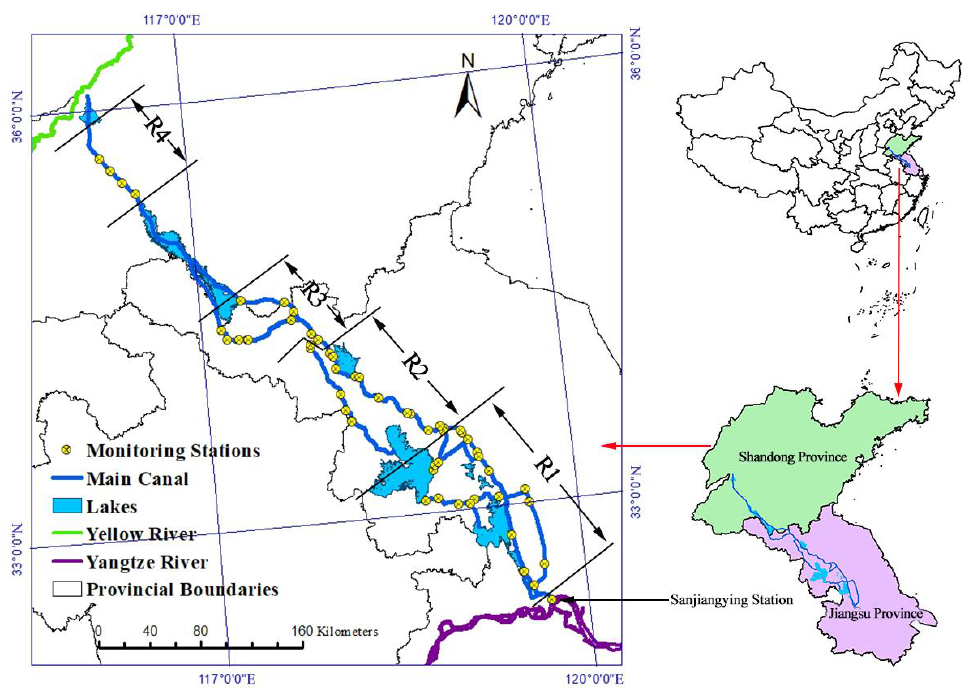
Figure 1. Map of the water quality monitoring stations along the mainline of the first phase of the SNWDPC-ER.